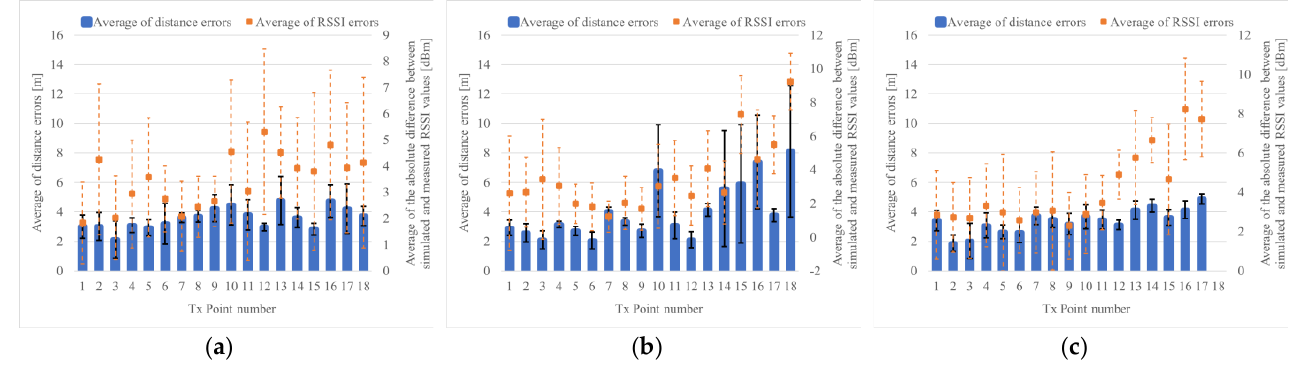
Figure 17. Position estimation results of the actual measurement using the minimum error up to the second ranked cluster in label group selection. (a) Result of Rx moves on left side, (b) Result of Rx moves on middle side, (c) Result of Rx moves on right side.